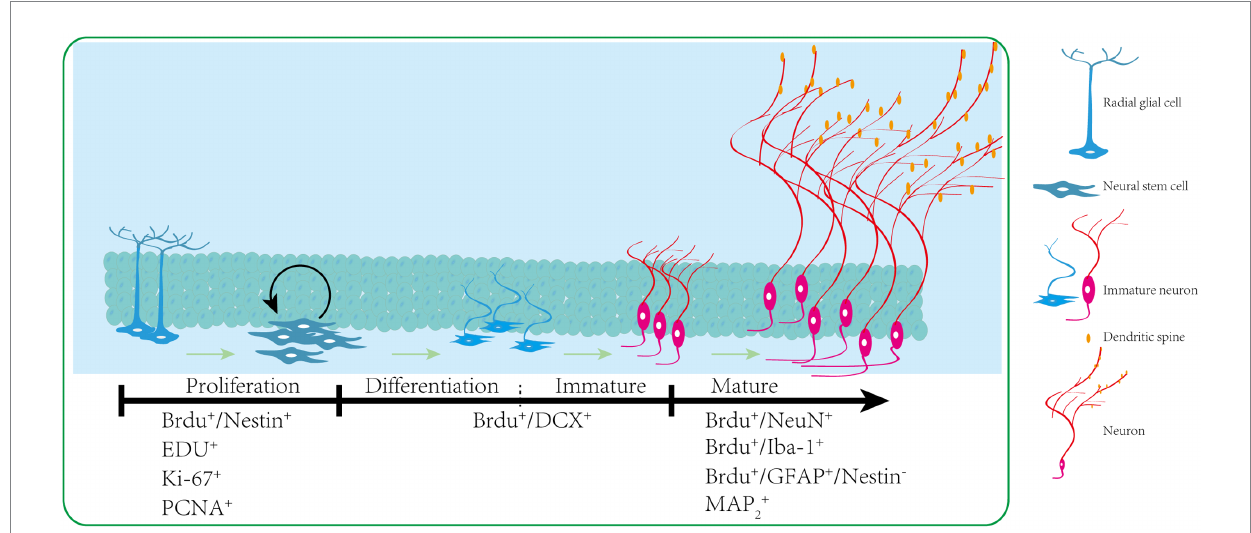
FIGURE 1 Adult hippocampus of the dentate gyrus. Newly formed neurons in the sub-granular zone of the dentate gyrus pass through several consecutive developmental stages. The radial glial cells can generate proliferating NSCs with transient amplifying characteristics. These NSCs can give rise to neuroblasts that subsequently differentiate into dentate granule neurons. The developmental trajectory is accompanied by the subsequent expression of stage-specific molecular